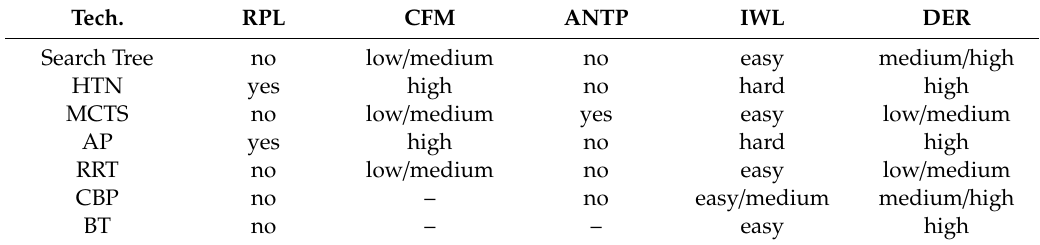
Table 3. Table presenting a comparison between the di ff erent planning techniques discussed. Similarly to what was done previously, while presenting a similar comparison for learning techniques and due to the same reasons, the aspects comprising the comparison are scored according to an overall score. The acronyms used stand for respectively: Requires a Planning Technique (RPL), Complexity of the Forward Model (CFM), Is Anytime Planning (ANTP), Integration with Learning (IWL), and Domain